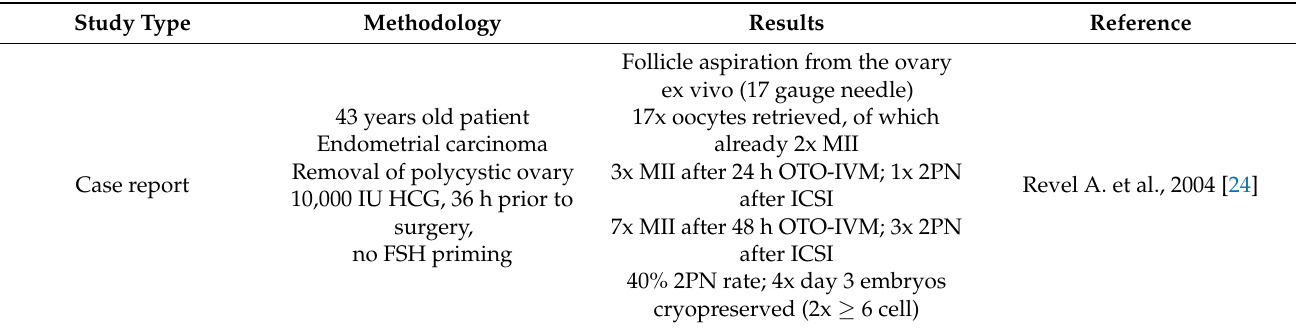
Table 1. Embryological and reproductive outcomes of human monophasic OTO-IVM.